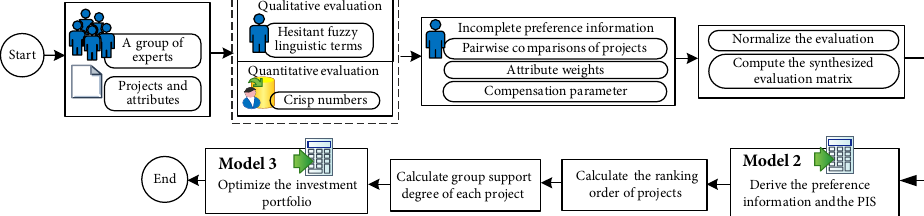
Figure 1. The flowchart of the two-stage mathematical programming model for PV project portfolio selection under incomplete preference